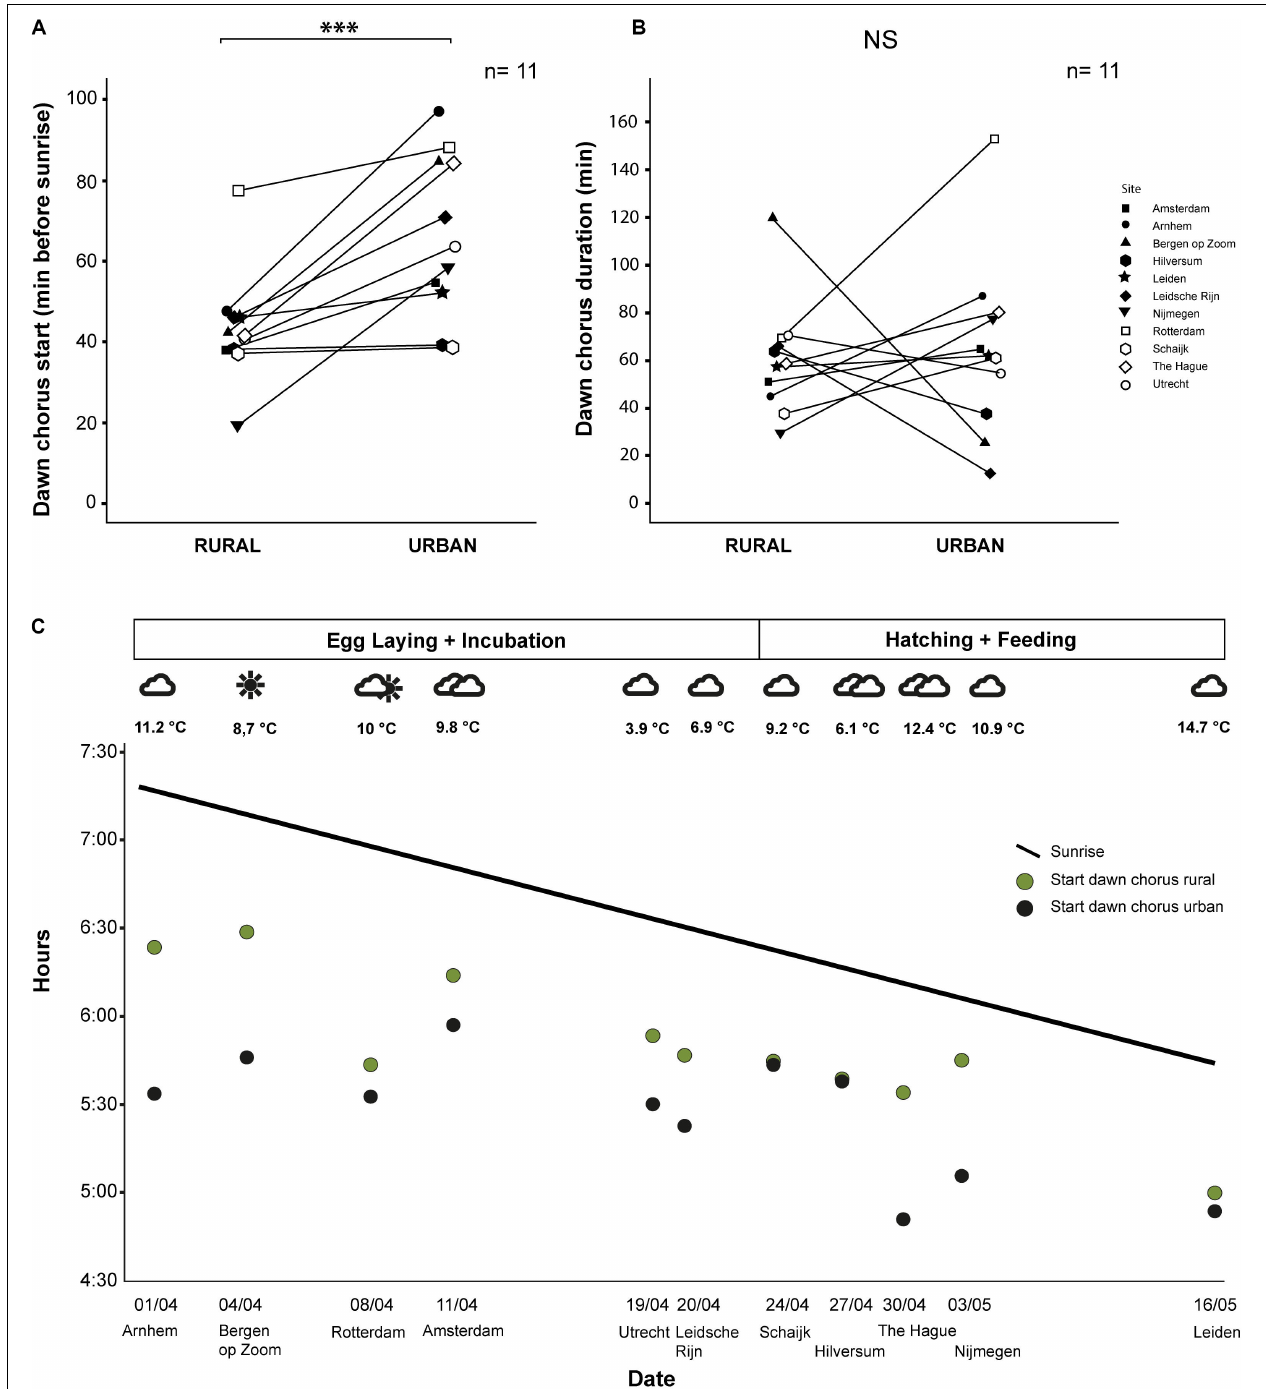
FIGURE 3 | Timing of singing for urban and rural great tits: (A) Dawn chorus start time relative to sunrise (*** means a significant difference at p < 0.001 level); (B) Duration of the dawn chorus (NS means not significant); and (C) Seasonal change of the start of the dawn chorus (line reflects changing sunrise). We indicated breeding phase and weather conditions for the sampling dates at the top and sampling date and pair location (by city name) at the bottom. See text for statistics.